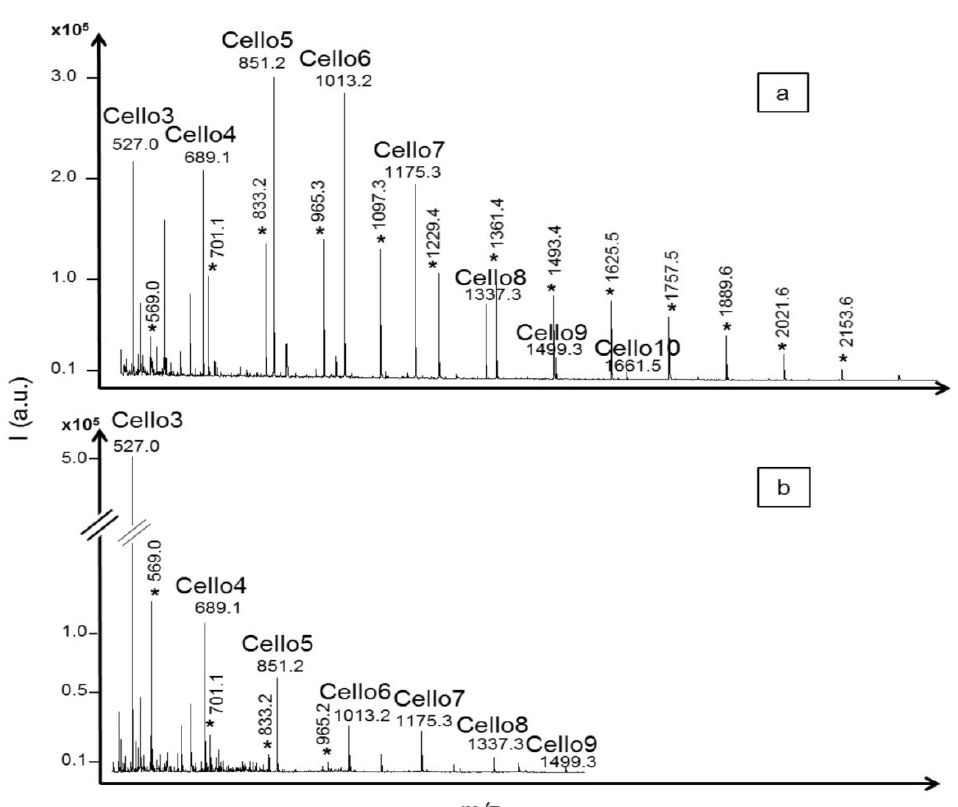
Figure 3. MALDI mass spectra of cellodextrins produced from α-cellulose hydrolysis by ( a ) trifluoroacetic acid (TFA) 2 M; and ( b ) a commercial cellulase from Trichoderma reesei . Degradation products of interfering xylan included in the α-cellulose substrate were also detected and identified as xylo-oligosaccharides based on their m/z values (from 569.0 * to 2153.6 * corresponding to four to 16 xylose units including one sodium